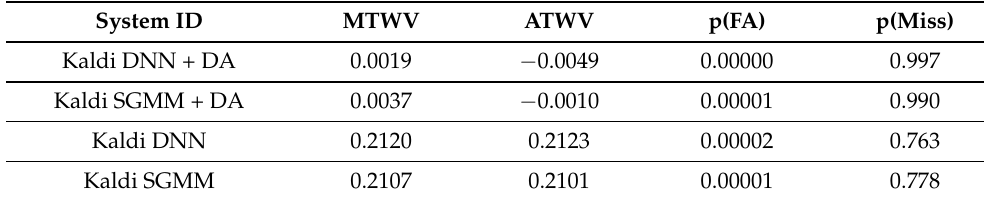
Table 11. System results of the STD task for RTVE test data.